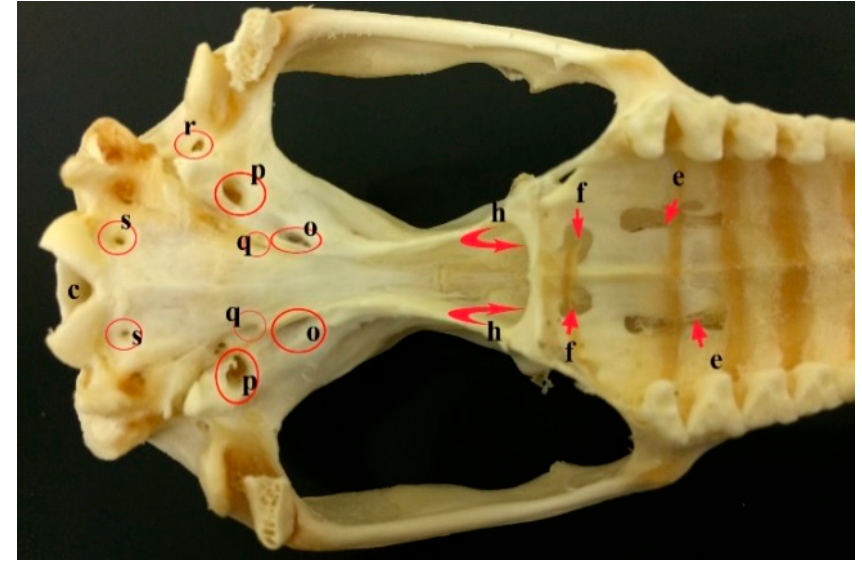
Figure 8. A photograph showing the foramina in the ventral aspect of the skull of the common opossum. c. foramen magnum; e. maxillopalatine fenestra; f. palatine fenestra; h. choanae; o. caudal alar foramen; p. carotic canal; q. transverse canal foramen; r. stylomastoid foramen; and, s. Hypoglossal canal.